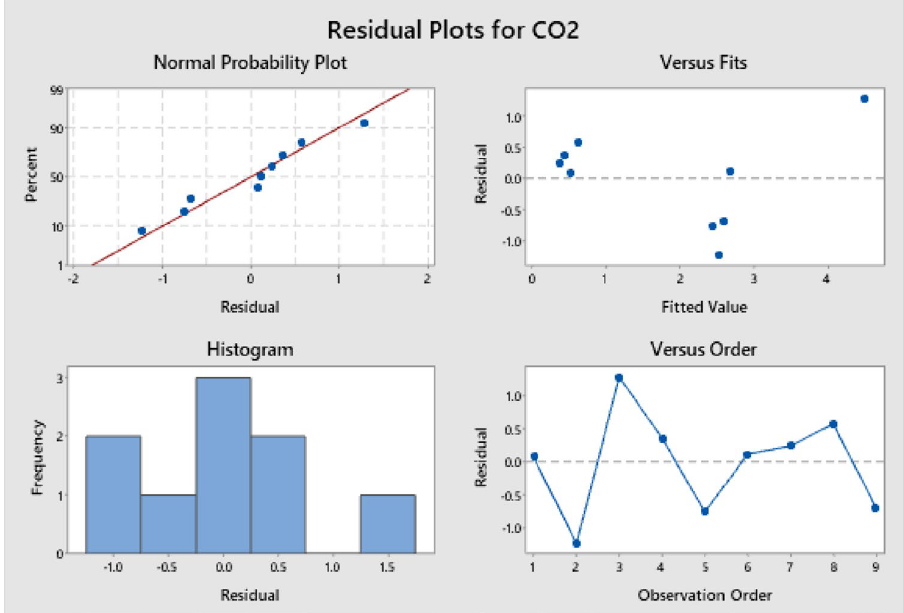
versus CuO (nano), load (kg), IMEP 2 2